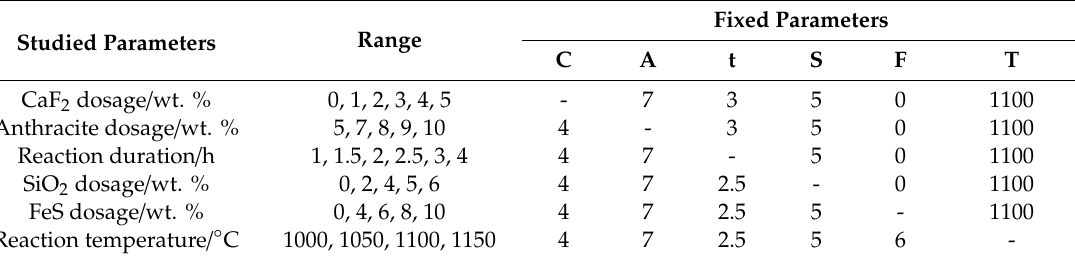
Table 2. Process parameters of the experiments.